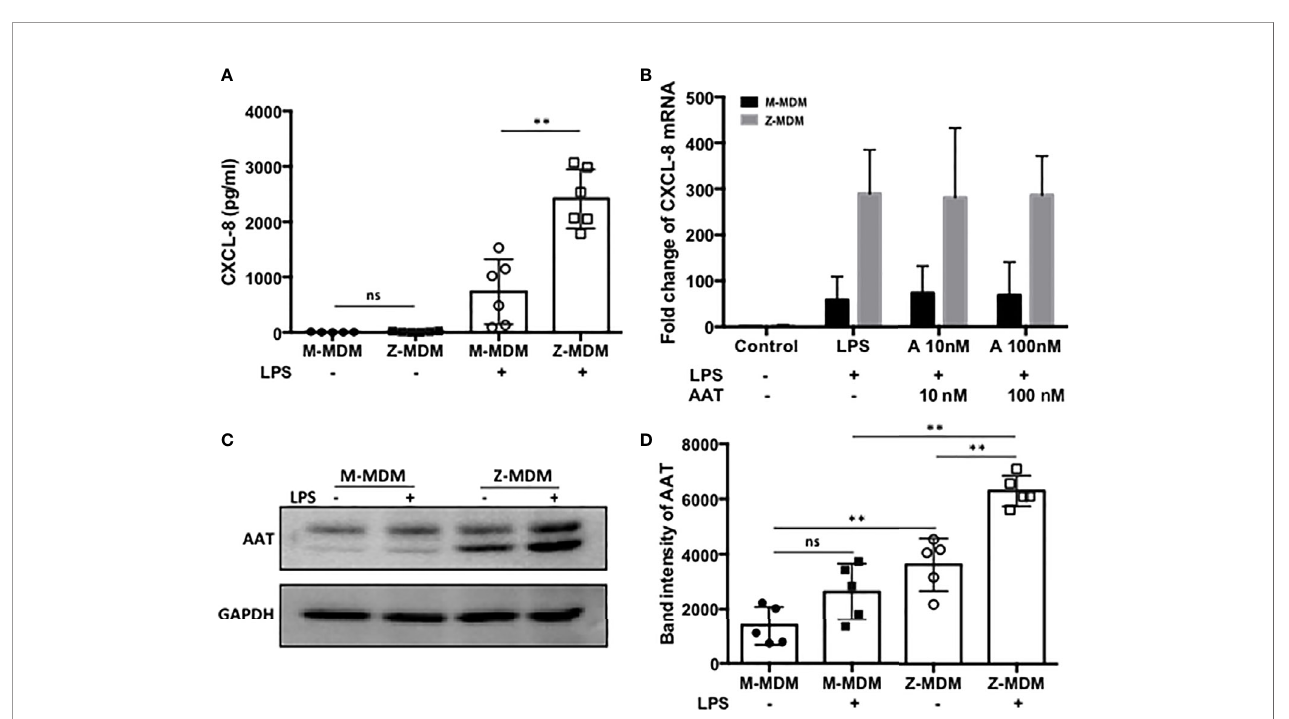
FIGURE 3 | A high level of CXCL-8 resulted from Z-AAT accumulation. MDMs were incubated with LPS (10 ng/ml) overnight. (A) CXCL-8 protein level was measured and compared between LPS-treated M- and Z-MDMs (n=6). (B) Two different concentrations of AAT were extracellularly added to M- and Z-MDM cultures and the cells were incubated with LPS and AAT overnight. Two-way ANOVA test was used to analyze the effect of genotype and treatment (AAT) on the expression of CXCL8 in the cells (n=5). P-values of interaction, genotype, and treatment were 0.96, 0.0001, and 0.996, respectively. *Denotes statistical signi fi cance (p-value < 0.05) according to two-tailed Student ’ s t-test. (C, D) Total proteins were collected from control and LPS-treated MDMs and the increased intracellular AAT levels in LPS-treated cells were visualized and quanti fi ed using western blotting (n=5). One-way ANOVA was used to compare the level of intracellular among the samples, and p-value was less than 0.0001. **Denotes statistical signi fi cance (p-value < 0.01) according to one-way ANOVA multiple